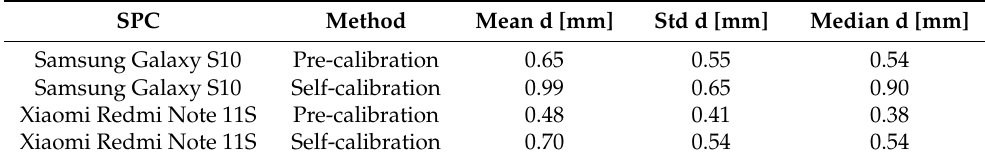
Table 4. Statistical measures characterizing the errors of 3D models relative to the reference model. SPC